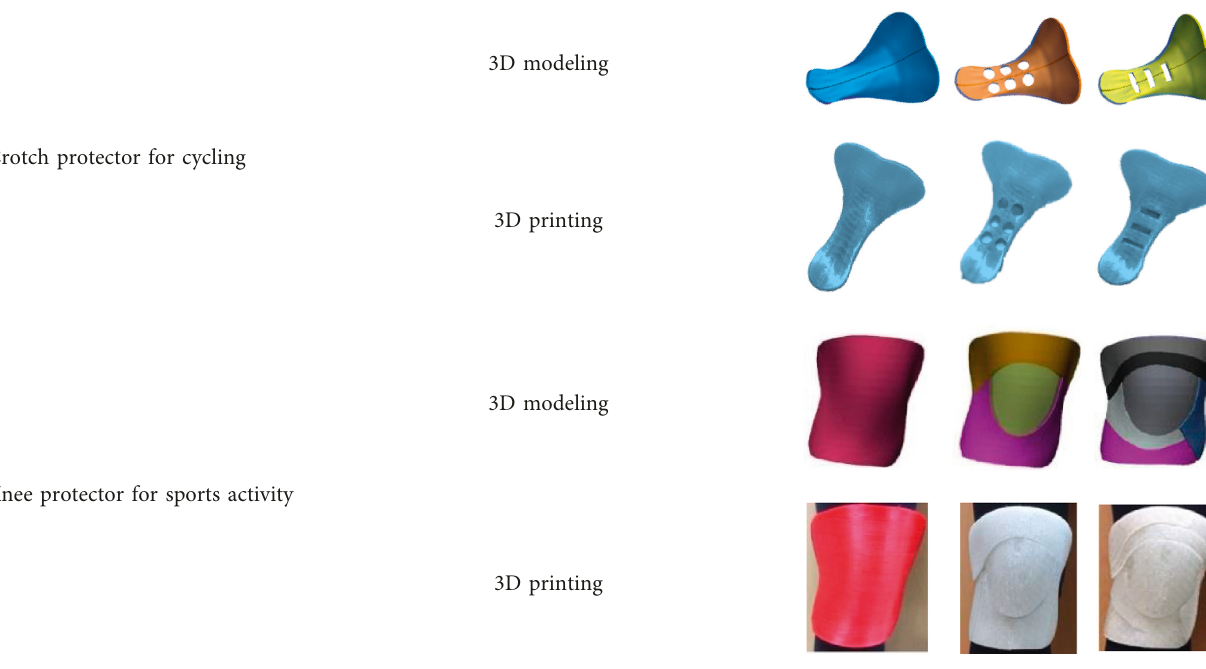
Table 6: Modeling and printout of crotch and knee protectors as example applications.